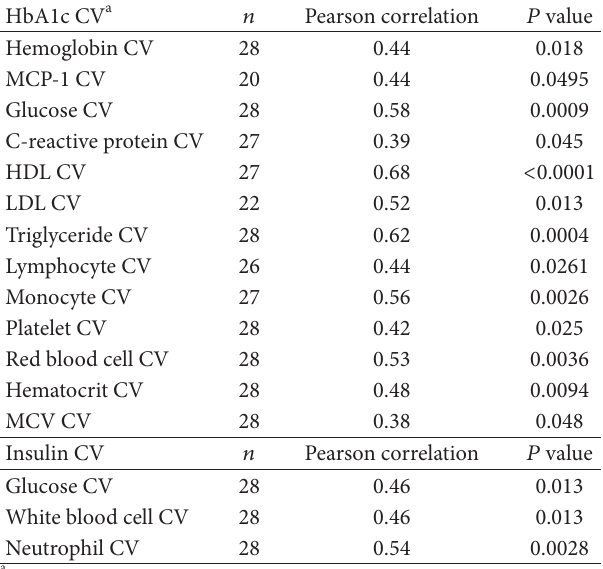
T 1: Correlations with individual treatment-naïve T2DM HbA1c and insulin coefficients of